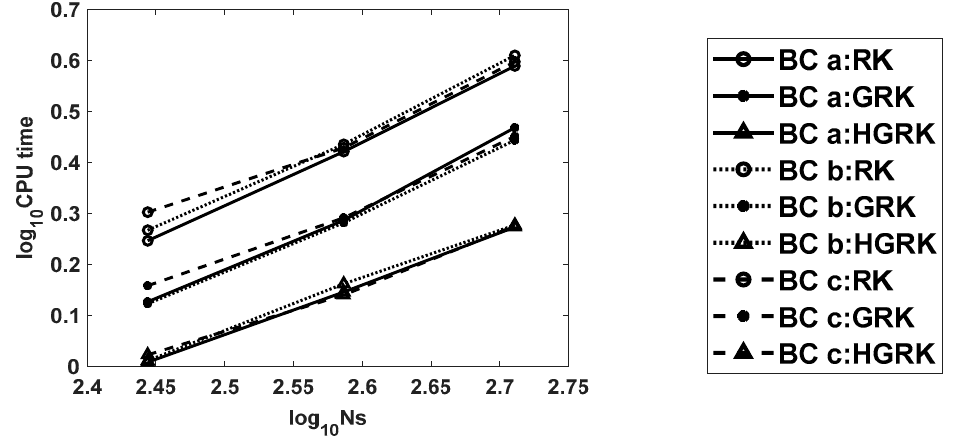
Figure 10. Comparison of CPU time by different methods in the annular domain.